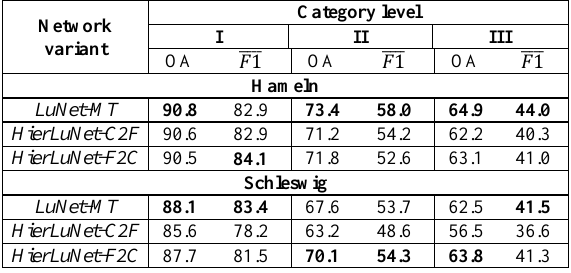
Table 2: Overview of the results of hierarchical land use classification for all network variants (cf. section